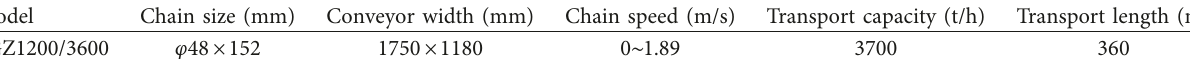
Figure 7: Transmission speed setting and vibration signal under normal condition. Table 3: Basic operating condition of the scraper conveyor.